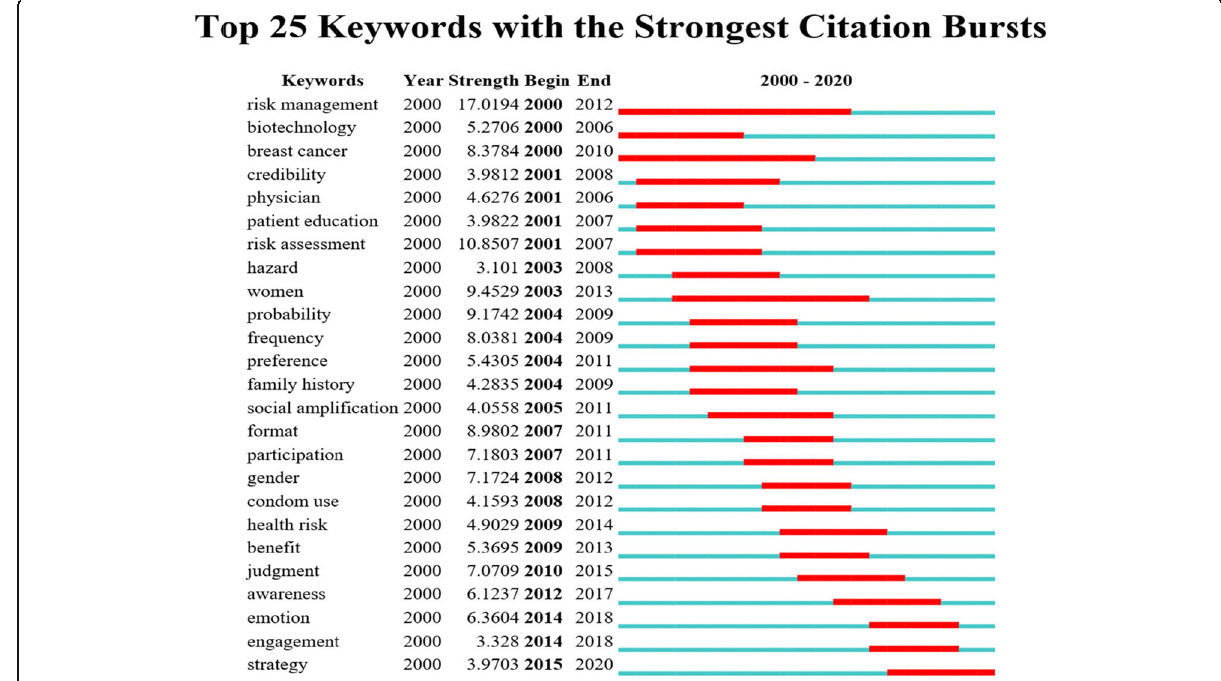
Fig. 6 Keywords with the strongest citation bursts of international